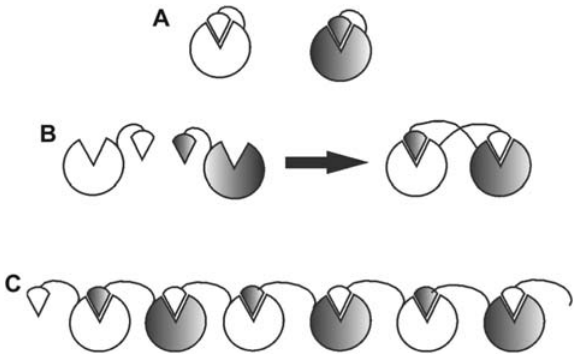
Figure 3 Sketch illustrating the mechanism of 3D domain swap- ping of a hypothetical protein. (A) Monomers. (B) Rotation around the hinges generates a swapped dimer. (C) Swapped